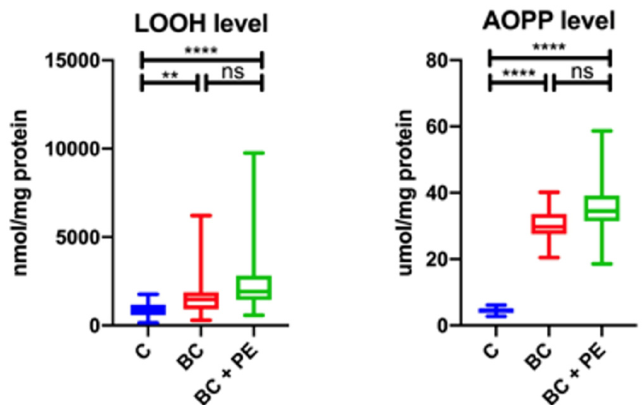
Figure 3. Comparison of results for LOOH and AOPP levels between the study groups. * p < 0.05,